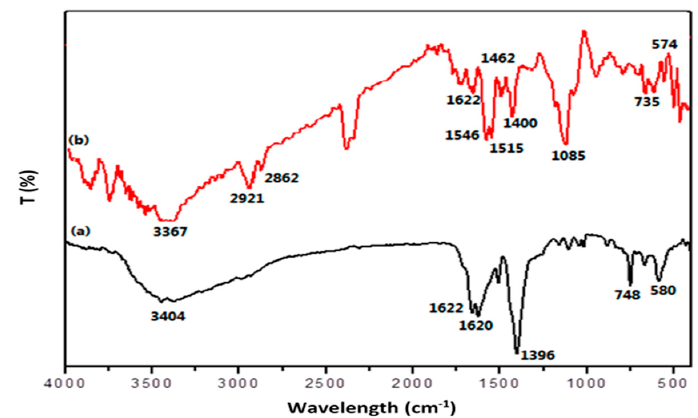
Figure 1. FT-IR spectra of ( a ) MIL-101(Cr) and ( b ) PPy@MIL-101(Cr) nanocomposite sorbent.